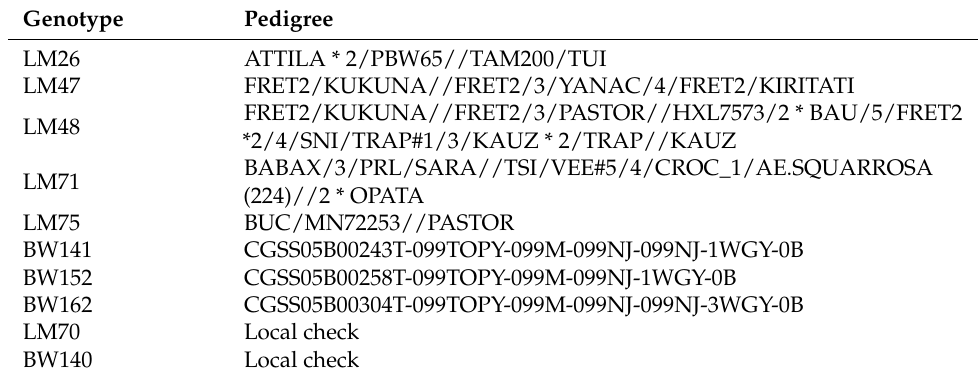
Table 4. List of the parental lines used in the